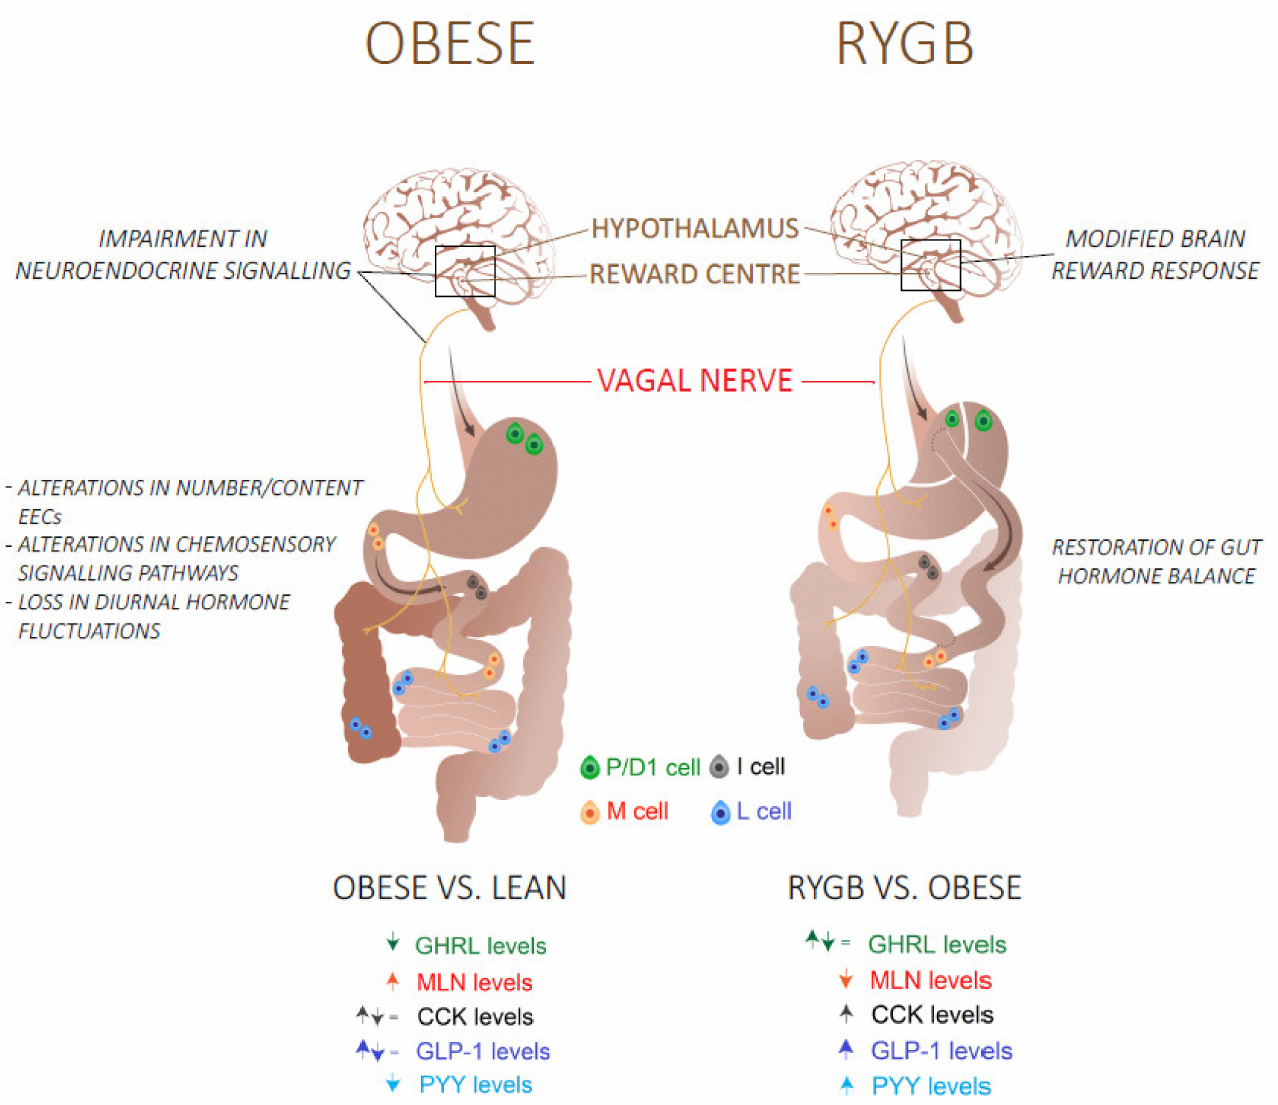
Figure 1. An overview of the mechanisms and the differences in fasting (GHRL, MLN) and postprandial (CCK, GLP-1, PYY) gut hormone plasma levels in obese/type 2 diabetes patients before and after a Roux-en-Y gastric bypass (RYGB) surgery. Abbreviations: GHRL: Ghrelin; MLN: Motilin; CCK: Cholecystokinin; GLP-1: glucagon-like peptide 1; peptide